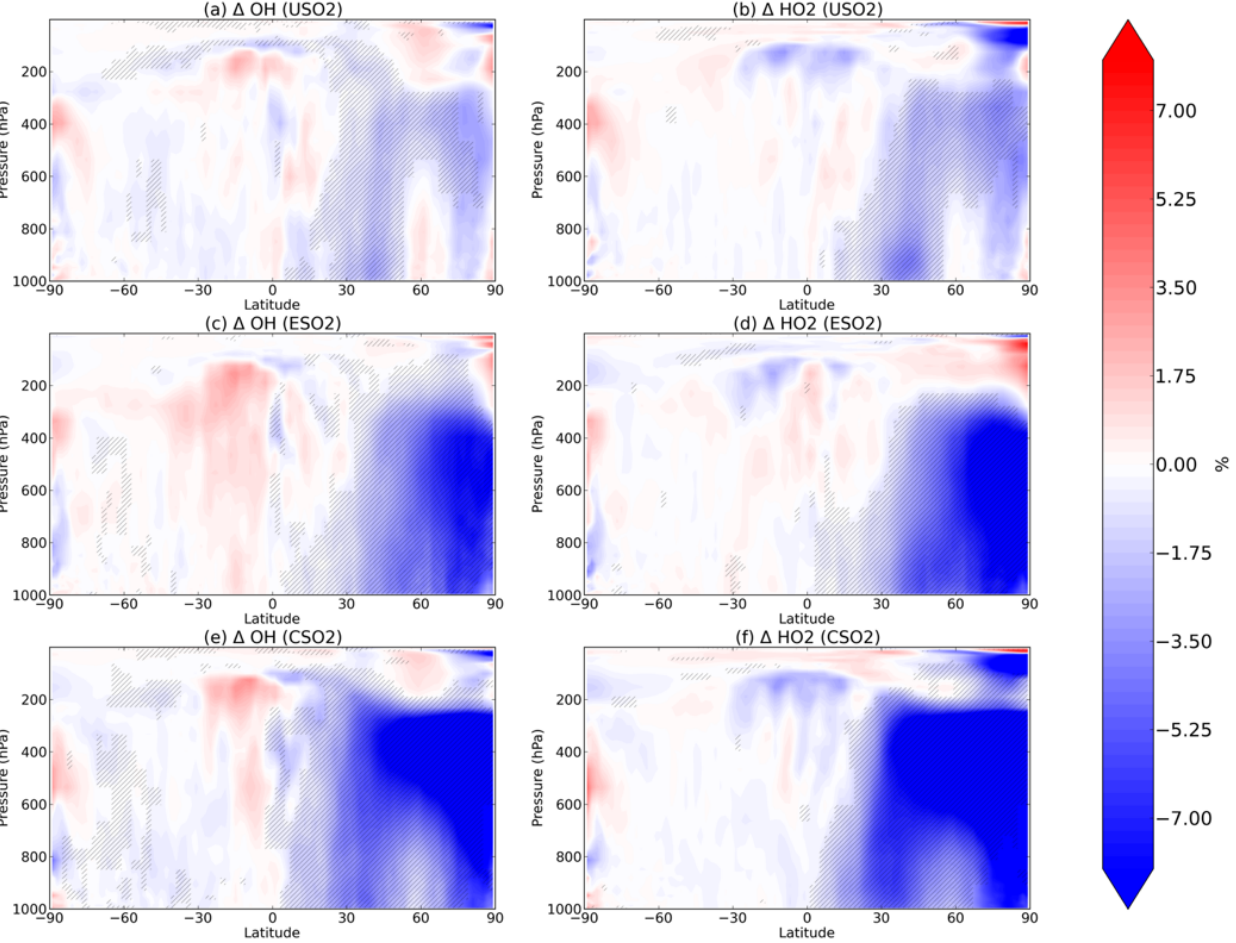
Figure 2. Boreal springtime (MAM) mean percent change in OH (a, c, e) and HO 2 (b, d, f) between a control simulation and a perturbation simulation in which anthropogenic SO 2 emissions are removed over a certain region: (a, b) US, (c, d) Europe, and (e, f) China. Hatching denotes statistical significance according to a Student’s t test at the 95% confidence